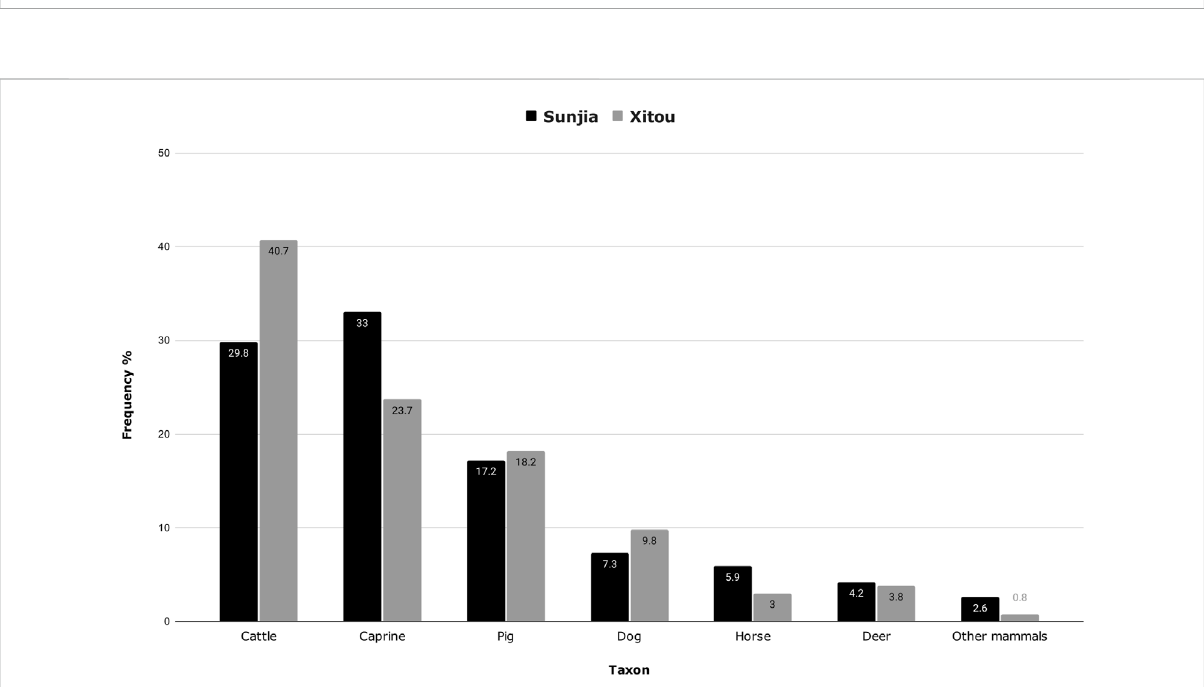
FIGURE 6 Frequency of different taxa from Sunjia and Xitou by